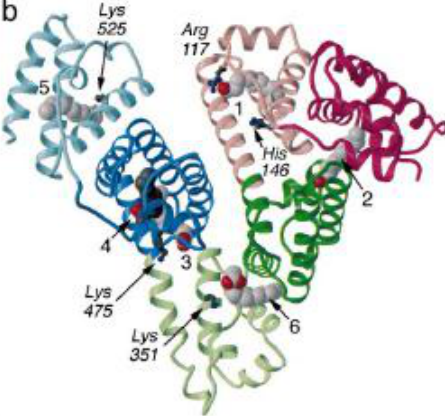
Figure 42. Binding of fatty acid to HSA induces significant conformational changes in the protein. ( a ) Crystal structure of unliganded HSA [223] (PDB ID, 1ao6). The subdomains are color-coded as follows: IA, red; IB, light-red; IIA, green; IIB, light-green; IIIA, blue; IIIB, light-blue. ( b ) Crystal structure of HSA-myristate [224] (PDB ID, 1bj5). Both crystal structures have been fully refined to 2.5 Å resolution. The six myristate molecules are numbered 1–6 and shown in a space-filling representation. Adopted, with permission, from [225]. Copyright 1999, Elsevier Science B.V.